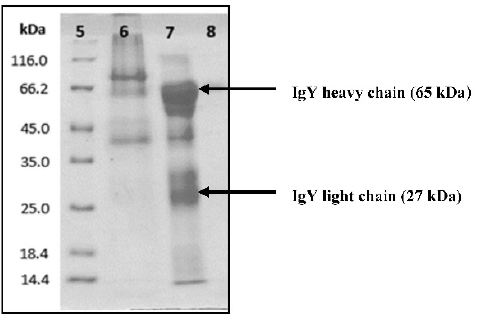
Figure 2. Identification and SDS-PAGE patterns of IgY anti-RBD spike SARS-CoV-2. Protein marker (lane 5), peak 1 (lane 6), peak 2 (lane 7), and peak 3 (lane 8).